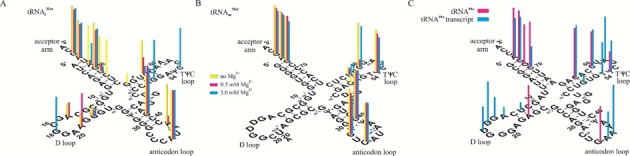
Isoenergetic microarray mapping results for tRNAiMet (A) and tRNAmMet (B) in 1 M NaCl, 20 mM sodium cacodylate, 0.5 mM Na2EDTA pH 7.5 (yellow bars), 1 M NaCl, 0.5 mM MgCl2, 10 mM Tris-HCl pH 7.5 (red bars) and 1 M NaCl, 3.0 mM MgCl2, 10 mM Tris-HCl pH 7.5 (blue bars). The height of the bar corresponds to strength of probe binding. Isoenergetic microarray mapping results for tRNAPhe (C) (red bars) and unmodified transcript (blue bars) in 1 M NaCl, 0.5 mM MgCl2, 10 mM Tris-HCl, pH 7.5 at 4°C. The height of the bar corresponds to strength of probe binding (33,63).